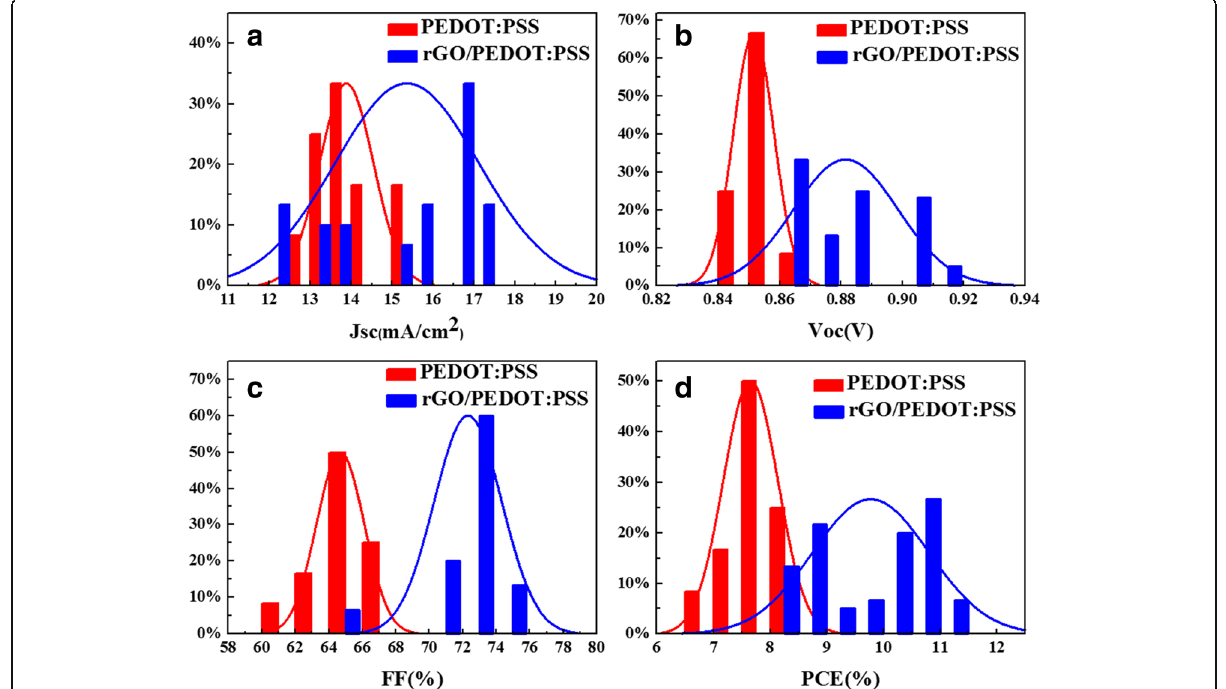
Fig. 6 Histograms of statistical photovoltaic parameters a V OC , b J SC , c FF, and d PCE for PSCs with pristine PEDOT:PSS as HTL and rGO/PEDOT:PSS as